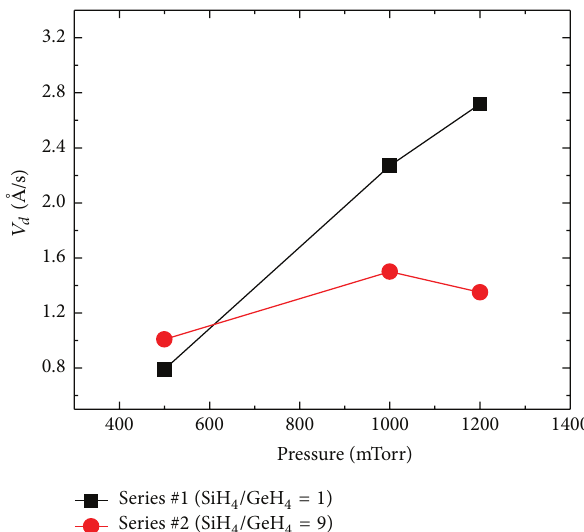
Figure5:Depositionrate( 𝑉 𝑑 )intwoseriesofdepositedfilms.Series #1: SiH 4 /GeH 4 = 1 and Series #2: SiH 4 /GeH 4 =